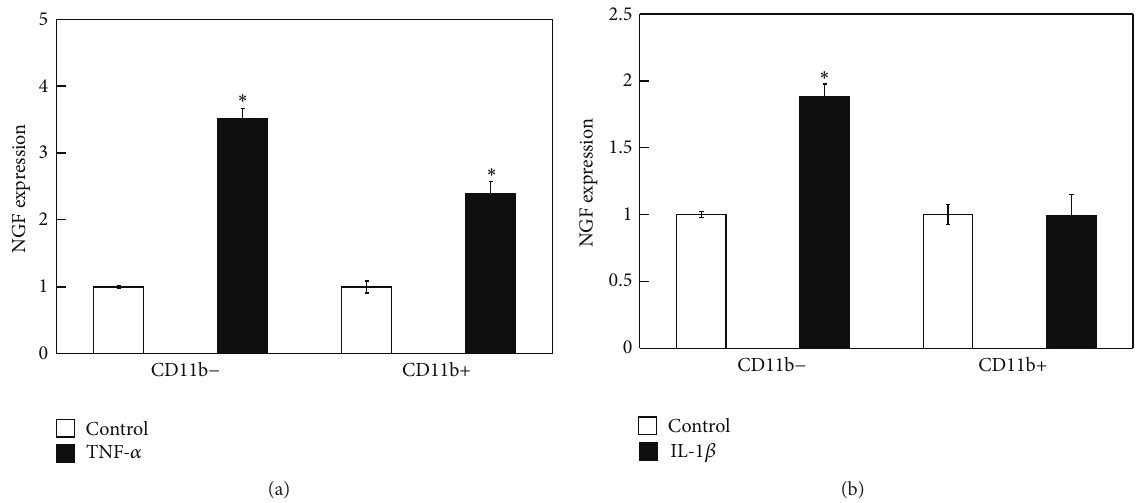
Figure 4: Effect of inflammatory cytokines on NGF gene expression in cultured synovial fibroblasts and macrophages. Effect of TNF- 𝛼 (a) and IL-1 𝛽 (b) on NGF gene expression in CD11b-positive and CD11b-negative cell fractions obtained from STR/Ort mice. ∗ 𝑝 < 0.05 versus control